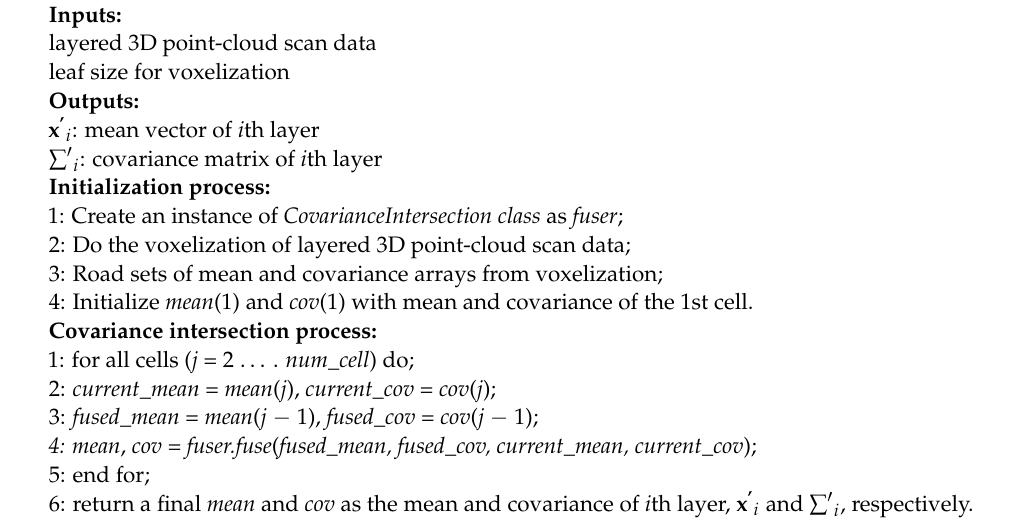
Algorithm 1 Pseudocode for the covariance intersection of multiple covariance